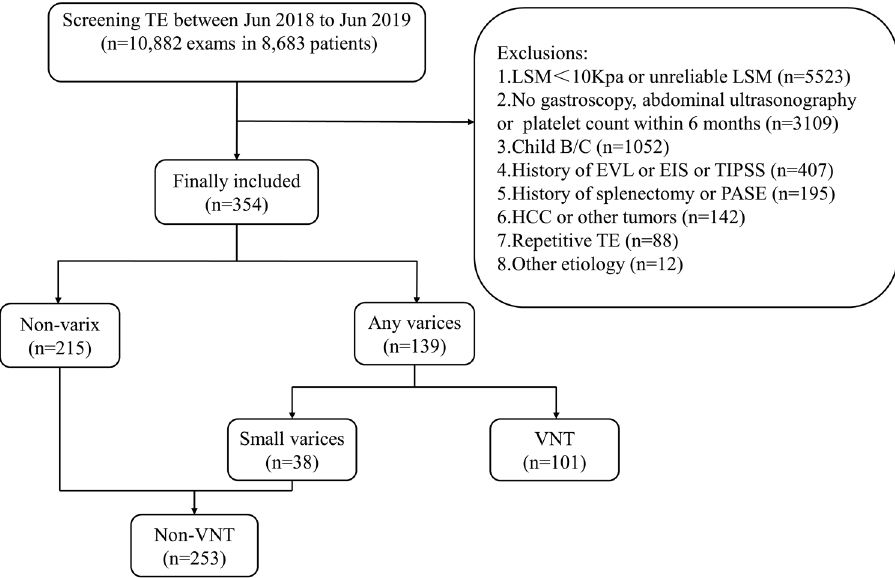
Figure 3. Flow chart of the study populations. TE, transient elastography; LSM, liver stiffness measurement; PLT, platelet count; INR, international normalized ratio; SD, spleen diameter; EVL, endoscopic variceal ligation; EIS, endoscopic injection sclerotherapy; TIPSS, transjugular intrahepatic portosystemic shunt surgery; PSE, partial splenic embolization; HCC, hepatocellular carcinoma; VNT, varices needing